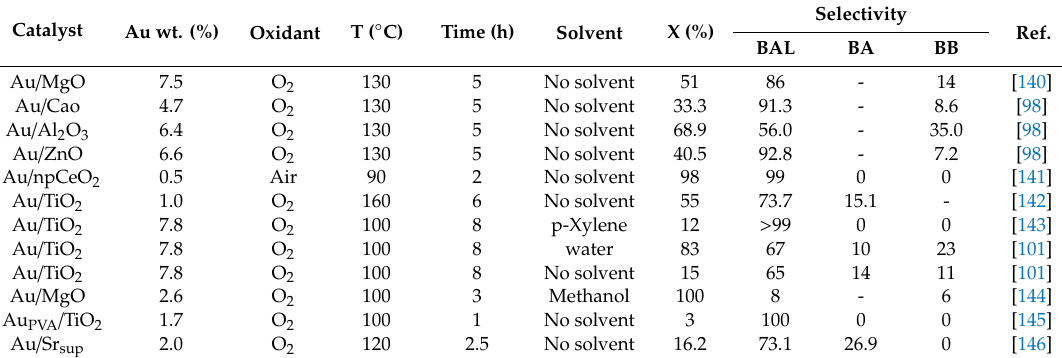
Table 2. Oxidation of benzyl alcohol over supported AuNPs